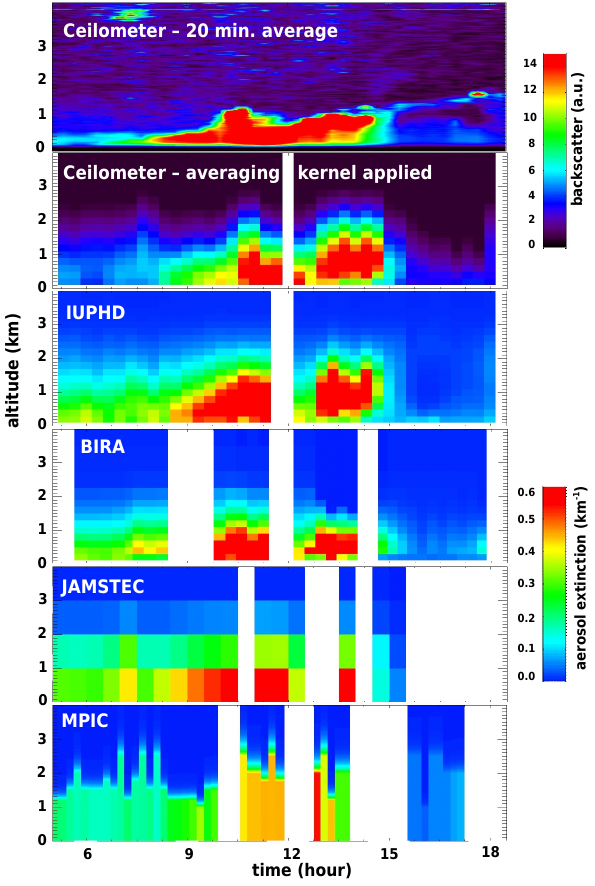
Fig. 17. Aerosol profile intercomparison for 3 July (Frieß et al., 2012). The top plot shows the backscatter profiles from the Ceilometer at Cabauw. The second plot shows the same data with MAX-DOAS averaging kernels applied. The plots below that show the aerosol extinction profiles of the MAX-DOAS instruments from BIRA-IASB, IUP Heidelberg, JAMSTEC and MPIC Mainz (top– down),